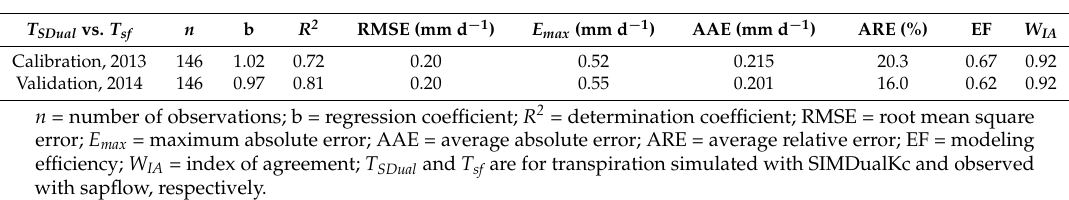
Table 3. Goodness of fit indicators relative to SIMDualKc predicted transpiration values when compared with observed transpiration data derived from sap-flow measurements.